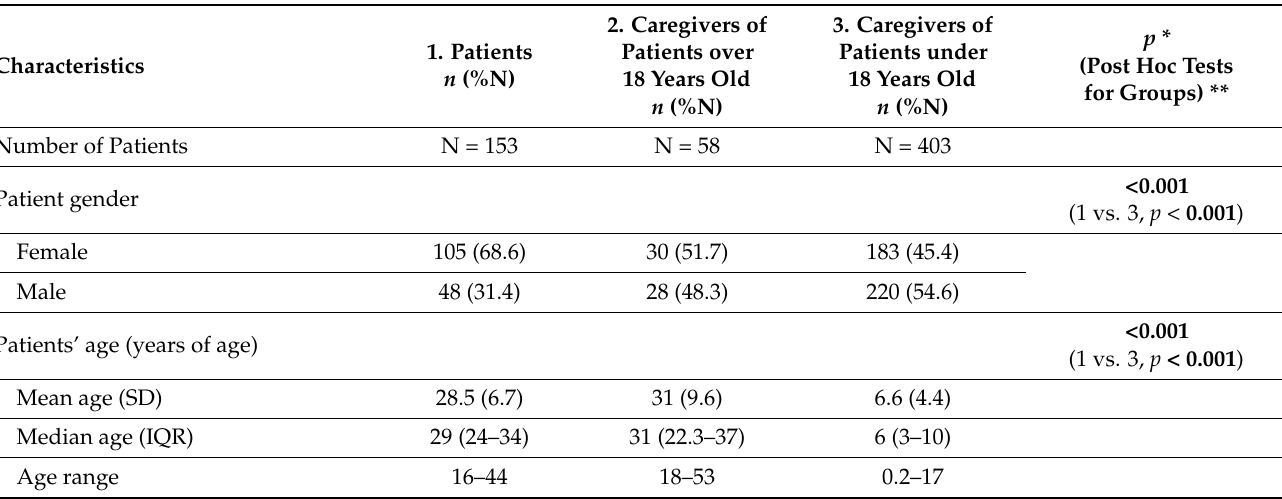
Table 1. Patients’